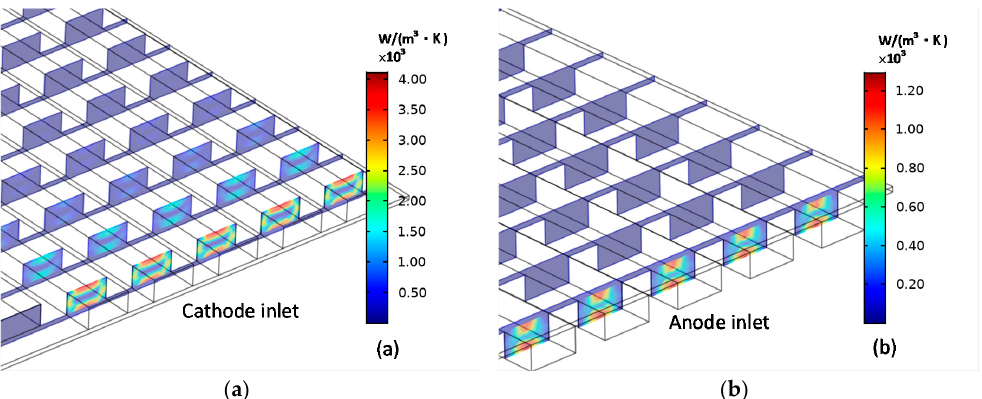
Figure 8. Cathode ( a ) entropy production and anode ( b ) entropy production caused by heat transfer.